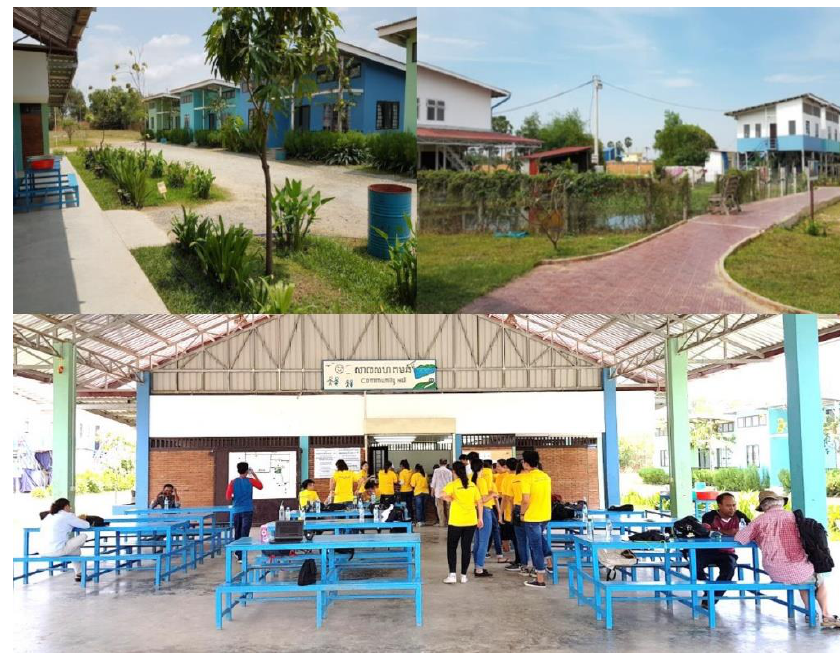
Figure 3. Community’s greenery and opened spaces. Source: Smile Village-Ouk Sovan.